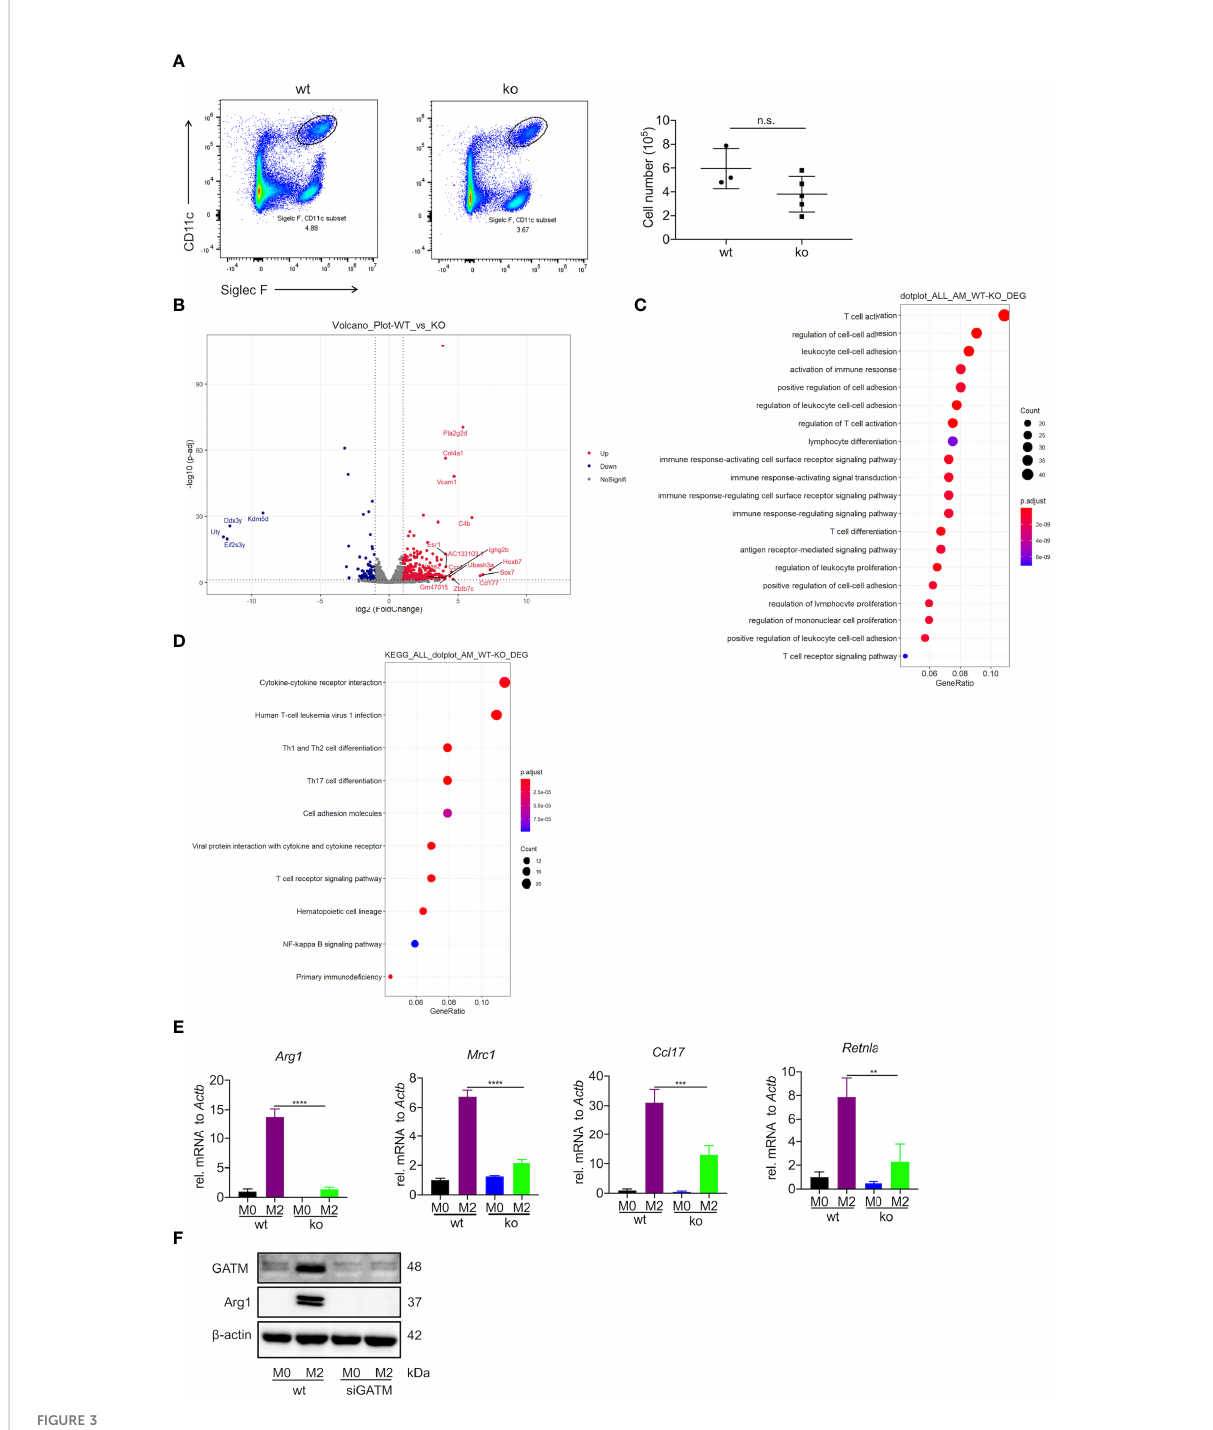
FIGURE 3 De fi ciency of GATM inhibits M2 polarization in AMs. (A) AMs maturation was detected by fl ow cytometry (n=3 – 5). (B) Volcano plot depicting GATM knockdown upregulation of signi fi cantly upregulated genes. Red dots represent signi fi cant upregulation of expressed genes and blue dots represent signi fi cant downregulation of expressed genes (GATM -/- vs. control) (C) Biological processes and (D) cell-signaling pathways related to AMs. Rich factor represents the number of differential genes/the total number of genes in the enrichment term; the greater the Rich factor, the higher the degree of GO/KEGG enrichment. Dot size represents the number of differential genes and the color of the dots represents the p-value in the enrichment analysis. siRNA blocks GATM expression in IL-4 activated (24 hours) AMs, (E) GATM and Arg1 protein expression was determined using western blotting (n=3). Data are expressed as mean ± SEM. Statistical signi fi cance was determined using one-way ANOVAs with Tukey ’ s multiple comparisons test; n.s., not signi fi cant ** P <0.01, *** P <0.001, **** P <0.0001. (F) and inhibit M2